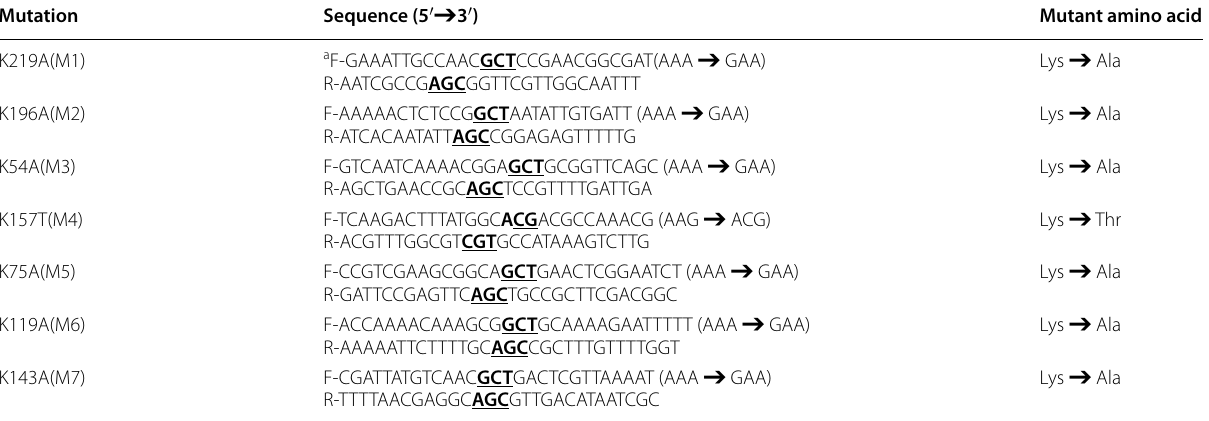
a Mismatches with the original sequence of the cel 5H gene are underlined